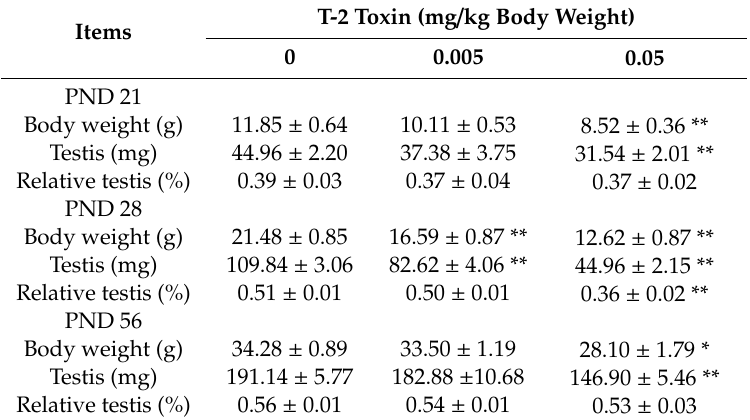
Table 2. E ff ects of maternal exposure to T-2 toxin on body weight and testicular weight of o ff spring.